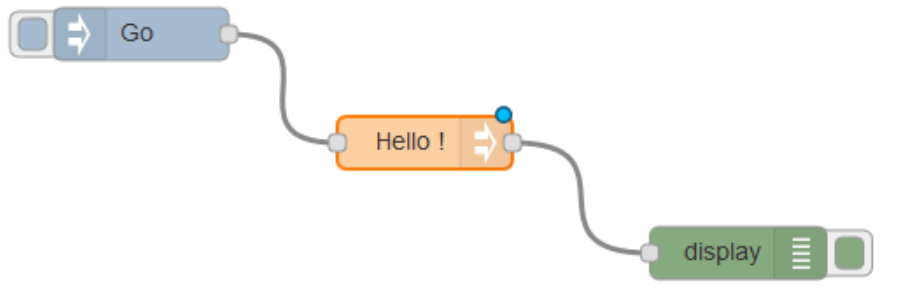
Figure 2. Example of a simple